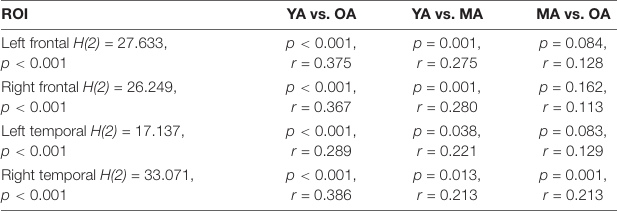
FIGURE 1 | Proverb interpretation. YA, young adults; MA, middle-aged adults; OA, old adults. TABLE 2 | Group differences in GM volumes in